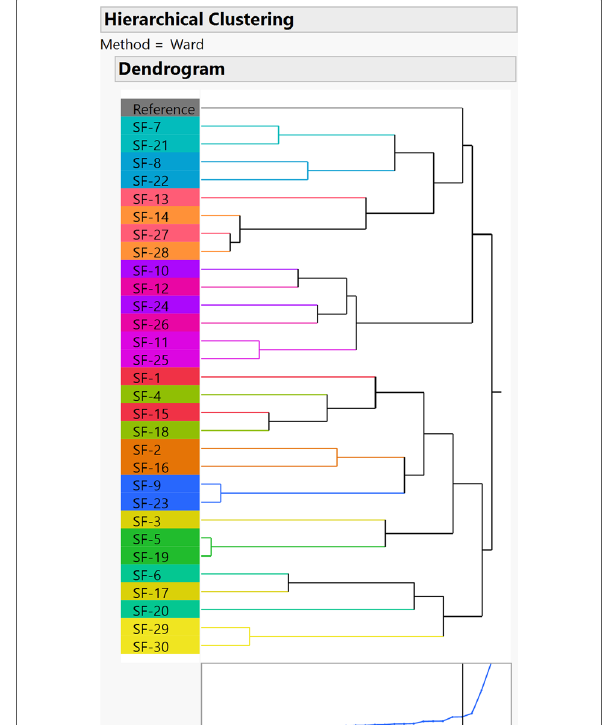
Fig. 2 Hierarchical clustering tree analyzed by JMP software. The duplicated runs are highlighted with the same sample color. Similar glycan pattern samples are clustered into one trunk. The samples share the same trunk with the reference, which means that they are similar to the